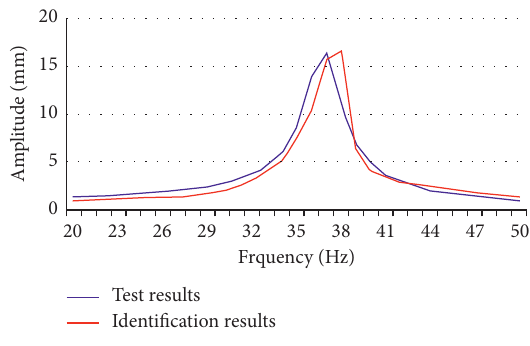
Figure 19: The comparison